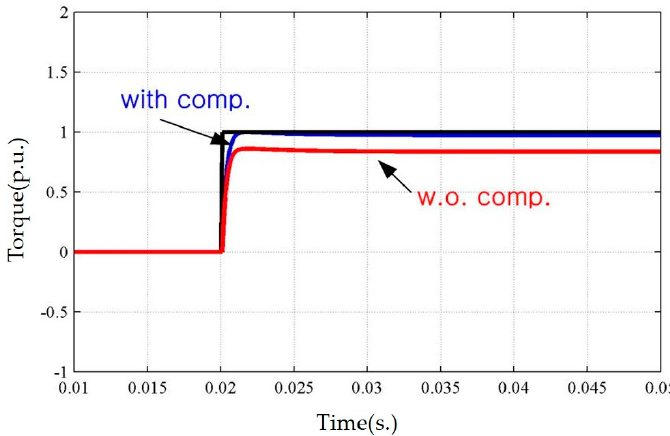
Figure 5. Simulation results of a torque response of a SPMSM drive with and without torque error compensation algorithm when a PM flux linkage is changed 20% from its initial value (Operating condition: ω r = 300 rad/s).